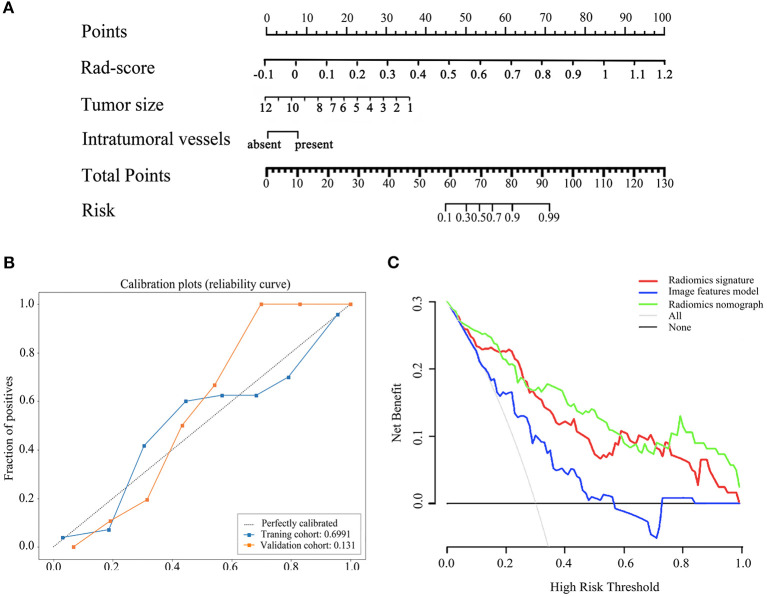
The radiomics nomogram, calibration curves of the radiomics nomogram and decision curve analysis. The radiomics nomogram was established based on radiomics signature, tumor size, intratumoral vessels in the training cohort (A). Calibration curves of the radiomics nomogram in the training and validation cohorts (B). The y-axis expresses the actual tumor necrosis rate, the x-axis expresses the predicted possibility and the 45°gray dotted line expresses the ideal prediction. Calibration curves demonstrated the goodness-of-fit of the radiomics nomogram. Decision curve analysis for three model. Decision curve analysis DCA) for each model in the validation dataset (C). The DCA demonstrated that if the threshold probability was >5%, the application of radiomics nomogram to predict tumor necrosis adds more benefit than treating all or none of the patients, radiomics signatrue and image features model.